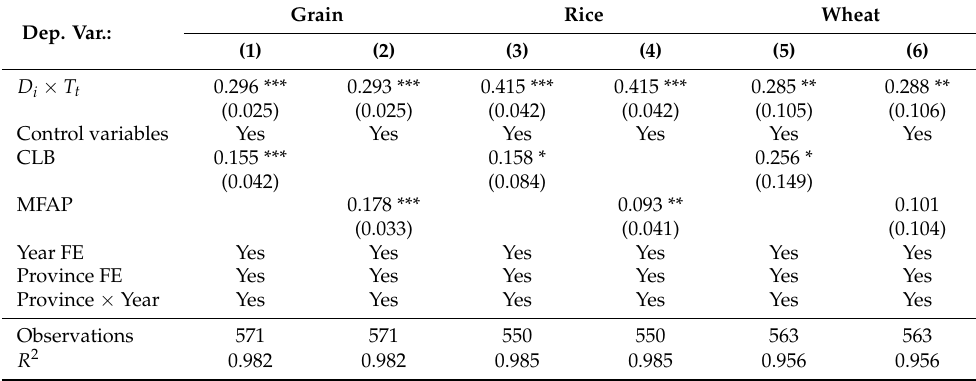
Table 10. Controls for other cultivated land spatial planning schemes. Dep. Var.: